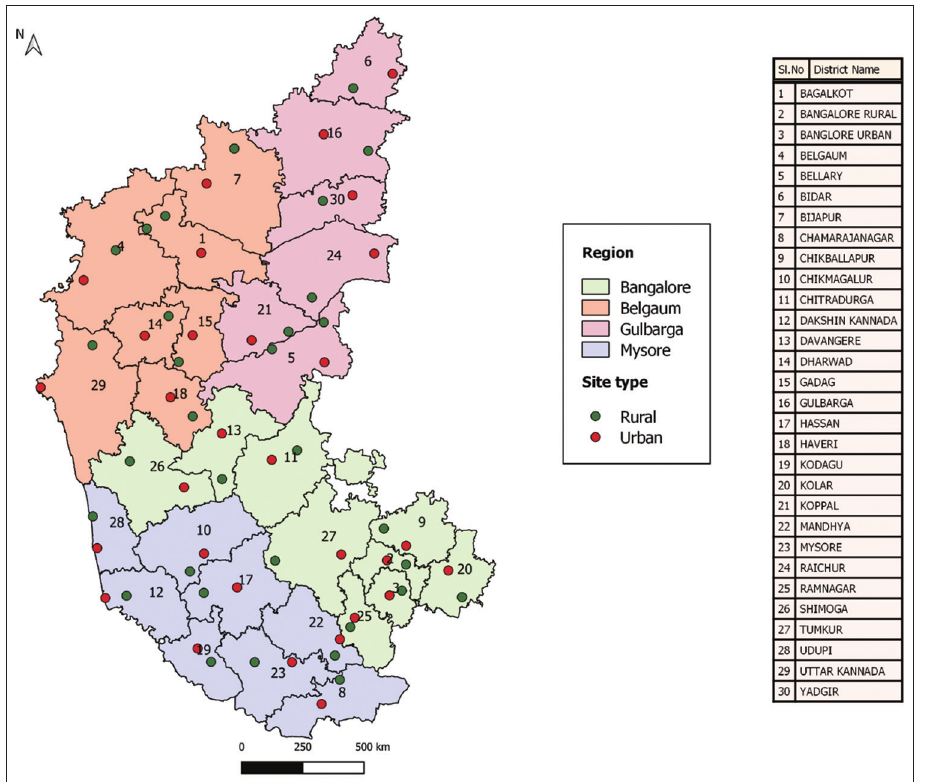
Figure 1: Distribution of HIV sentinel surveillance sites in Karnataka –